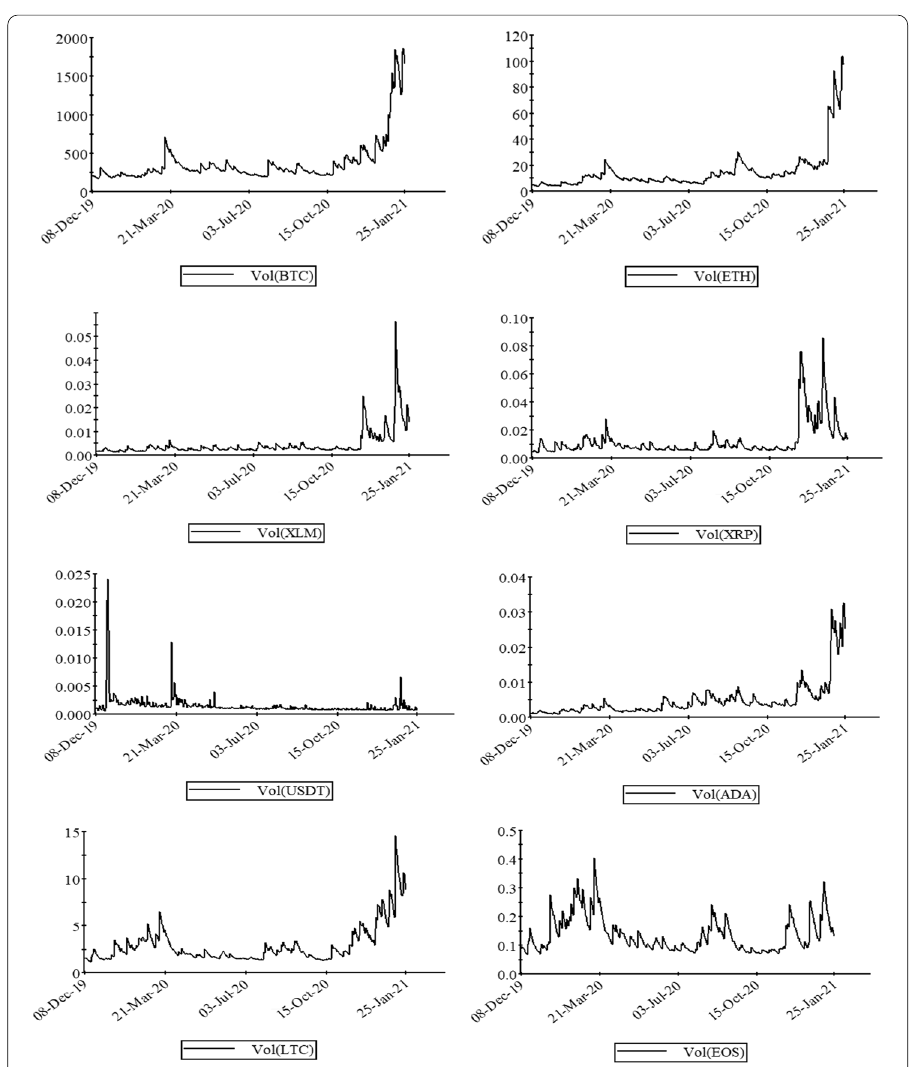
Fig. 3 A plot of conditional volatilities of daily